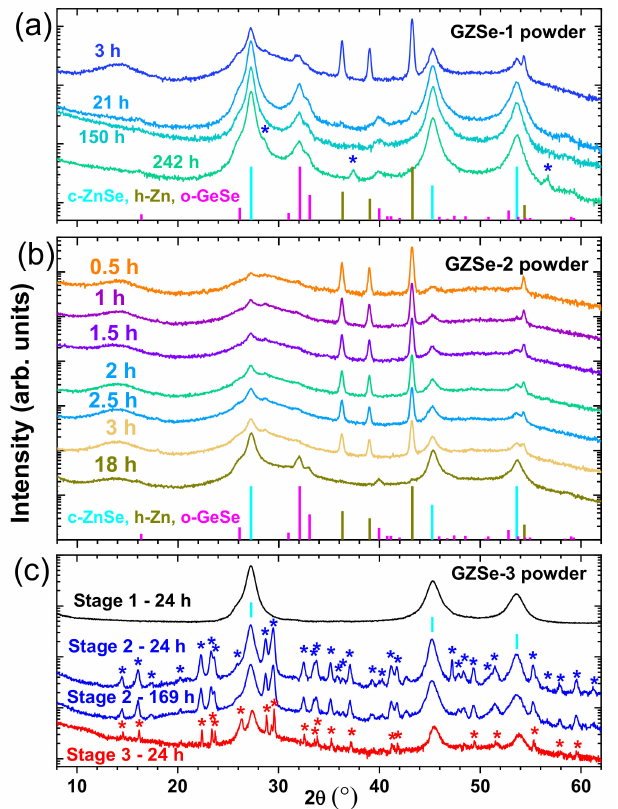
Figure 2. X-ray diffraction patterns of ( a ) GZSe-1, ( b ) GZSe-2, and ( c ) GZSe-3 powders taken at different milling times. The intensity is represented in logarithmic scale to make more visible the low intensity peaks, while the XRD patterns are expanded on the y-axis scale for clarity. The peaks of the unidentified phases are indicated with